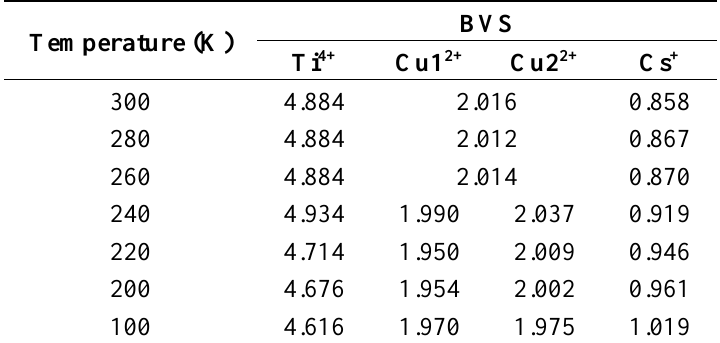
Figure 7. Tilting of TiF 6 octahedra (foreground) in an A-B-A-B fashion against a Cu–F kagome background as found in Cs 2 TiCu 3 F 12 below the rhombohedral → monoclinic transition temperature. Table 5. Bond valence sums for the cations in Cs 2 TiCu 3 F 12 as a function of temperature (VaList. [17]). Bond lengths derived from SXPD